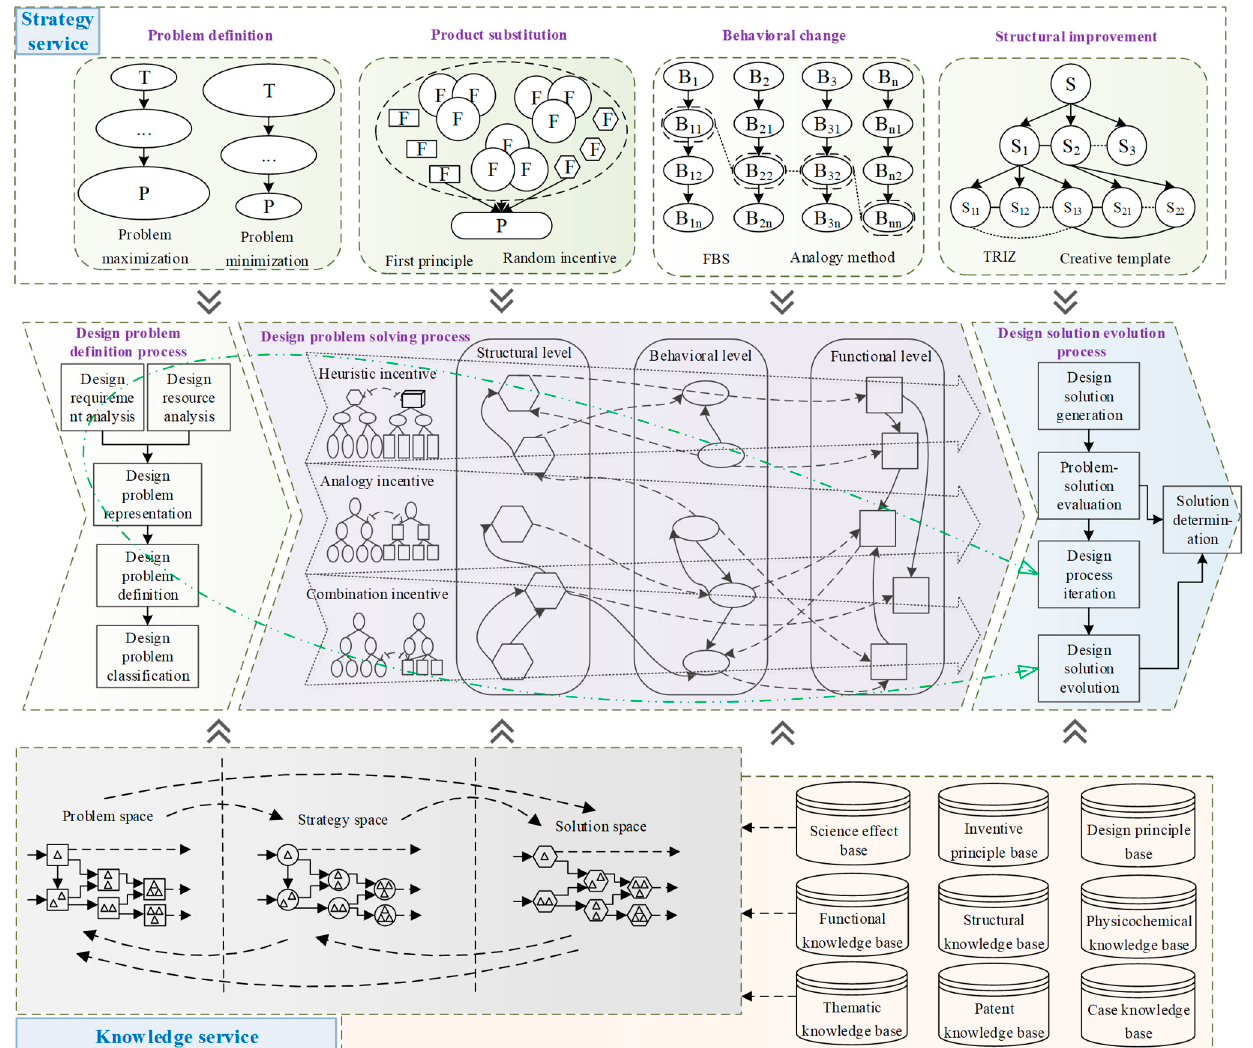
Figure 5. Knowledge service model of solution evolution based on design iteration.